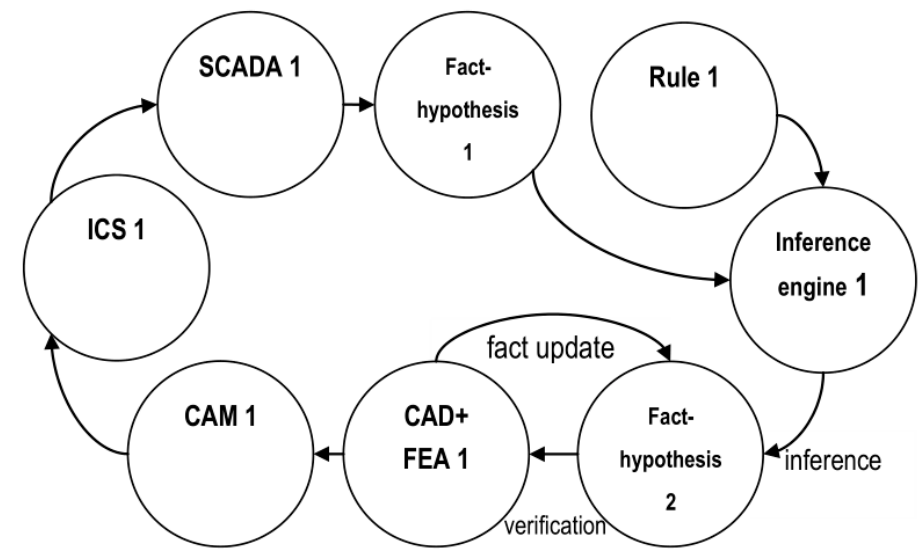
Figure 2. An example of a multi-agent PLM system.